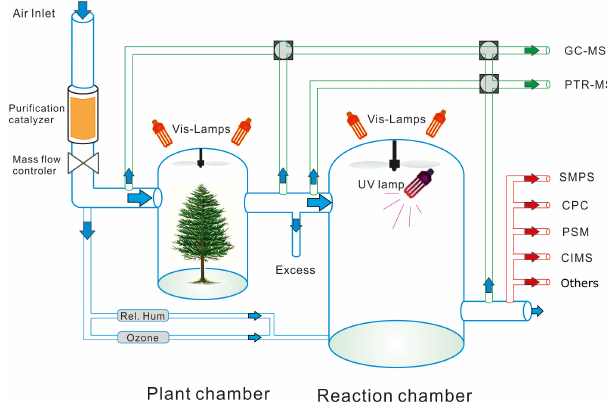
Figure 1. A schematic illustration of the Jülich Plant Chamber (JPAC) set-up as it was during the experiments presented